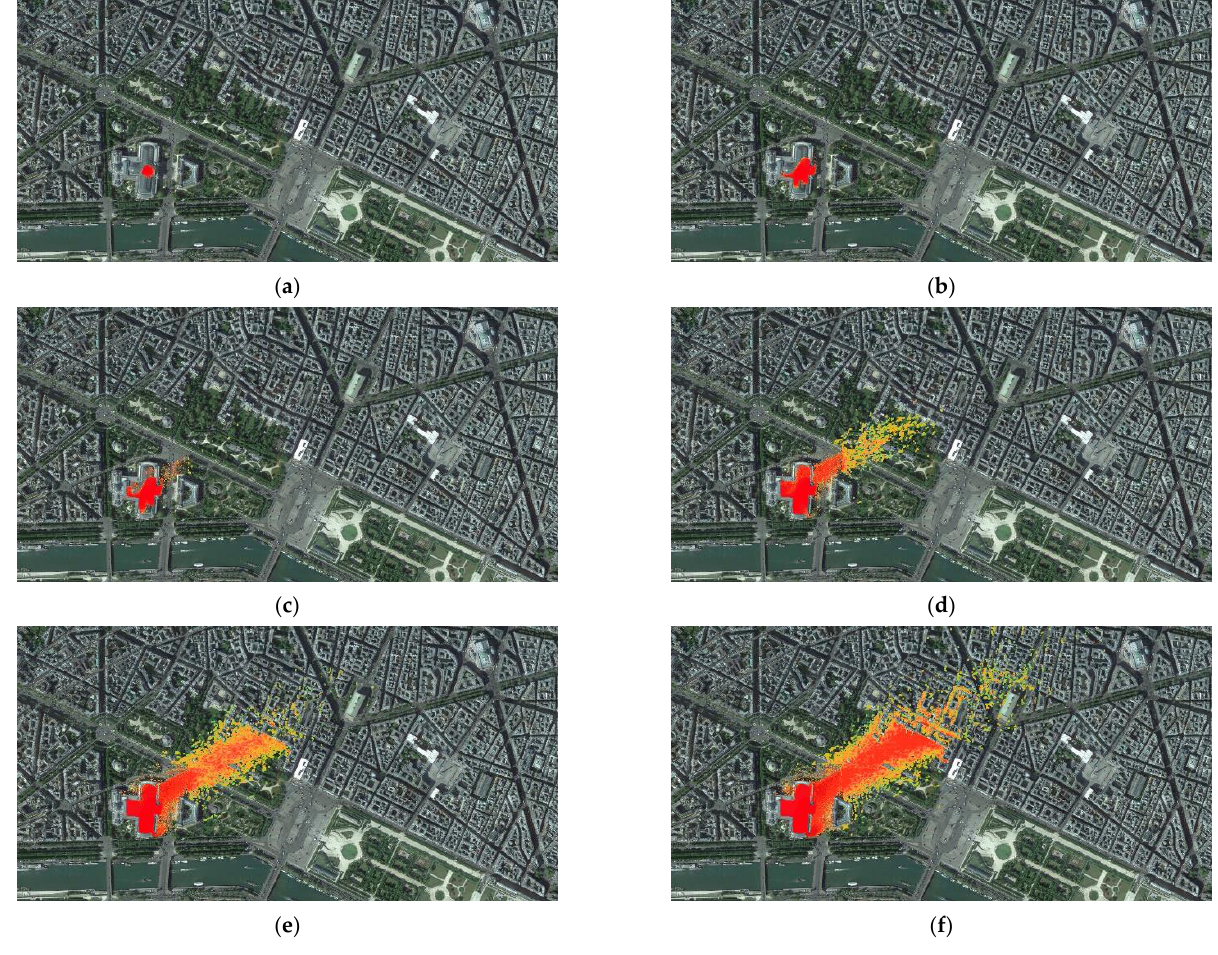
Figure 8. View, for the EMERGENCIES project, of the plume inside and in the vicinity of the museum: ( a ) 1 min after the release; ( b ) 3 min; ( c ) 4 min; ( d ) 6 min; ( e ) 8 min; ( f ) 10 min. The change from the 1-m resolution of the inner domain to the 3-m resolution of the large domain can be noticed. The threshold for 500 µg/m 3 of concentration is in red, while that for 1 µg/m 3 is in orange and that for 0.001 µg/m 3 is in green. North is at the top.